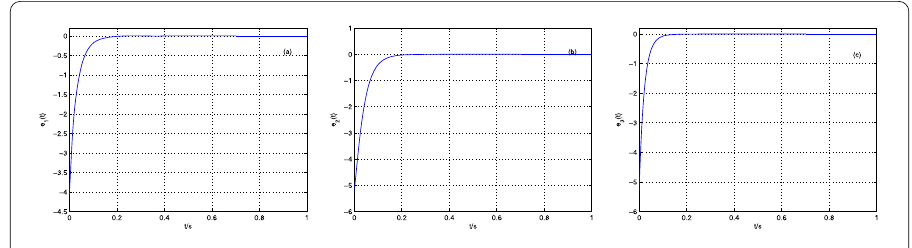
Figure 6 Time waveforms of synchronization errors e 1 (a), e 2 (b) and e 3 (c) between two fractional-order Lorenz